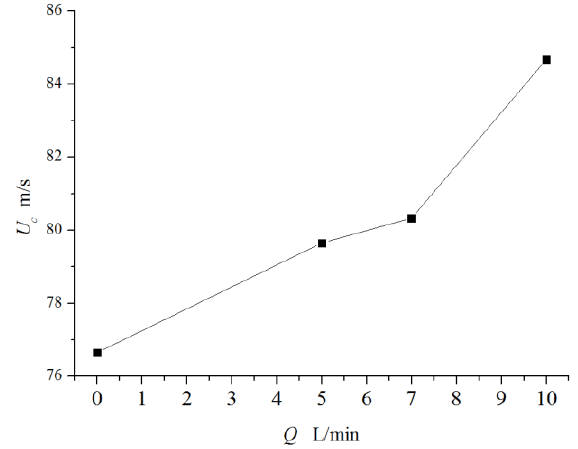
Figure 13. Flutter wind speed versus suction flow rate.